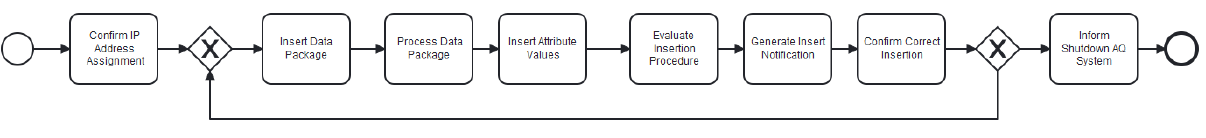
Figure 8. BPMN process model discovered using Repository Management Service event